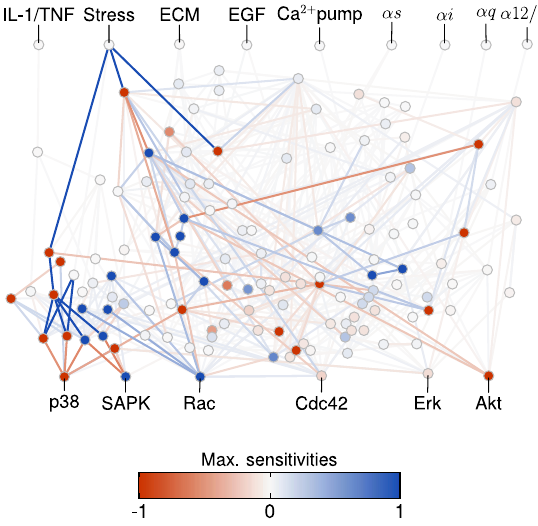
Figure 6. Maximum sensitivity of nodes and edges to chatter variation for periodic input stress. Red (blue) color scales for negative (positive) values of the sensitivity. Only a few nodes and edges present a high maximum (in absolute value) sensitivity. Most of these few nodes and edges are part of at least one of the paths previously identified as dominant (see Figures 4 and 5). The major part of nodes and edges not involved in information paths are robust to chatter, since they are mostly insensitive to